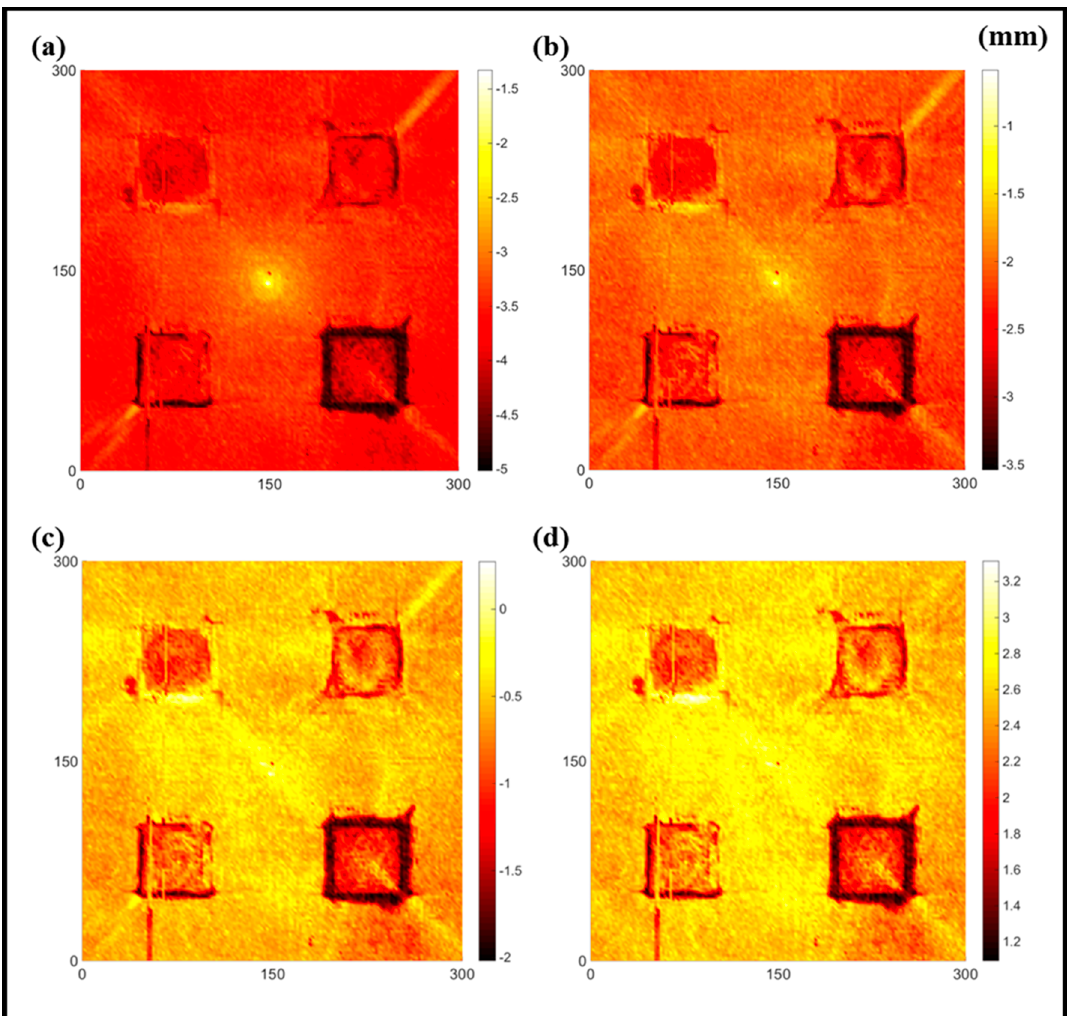
Figure 8. The RMS values distribution of log( w RMS ( x , y )_ W k ) function for Specimen 1 with the depths of 0.5, 1.0, 1.5, and 2.0 mm at 400 μ s: ( a ) k = 0; ( b ) k = 0.5; ( c ) k = 1; ( d ) k = 2.